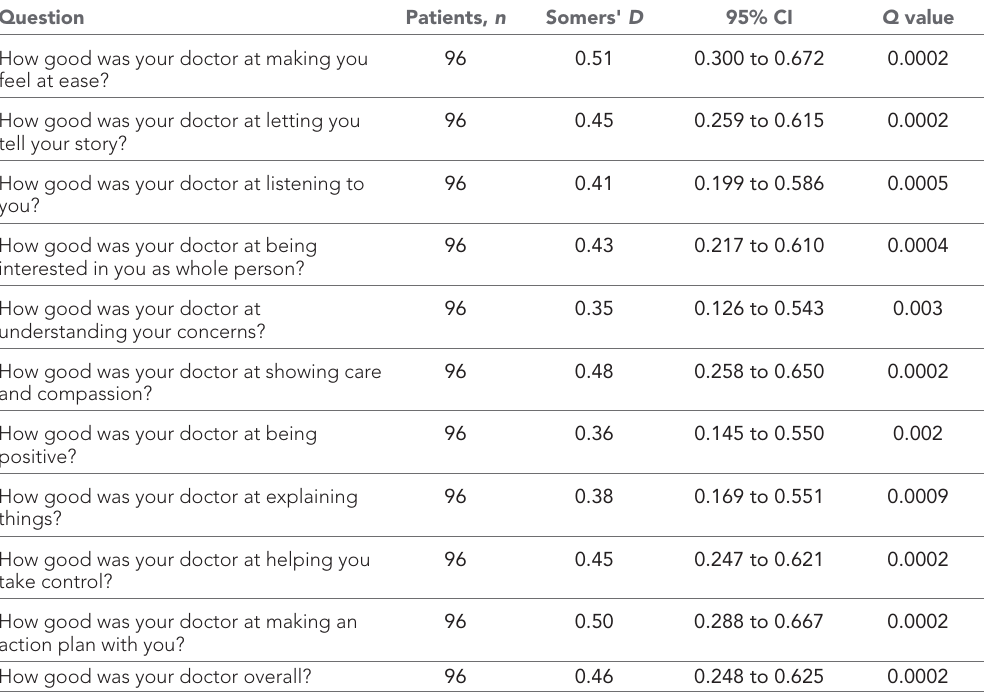
Table 1 Somers' D of patient response with respect to diplomate status of doctor Question Patients,